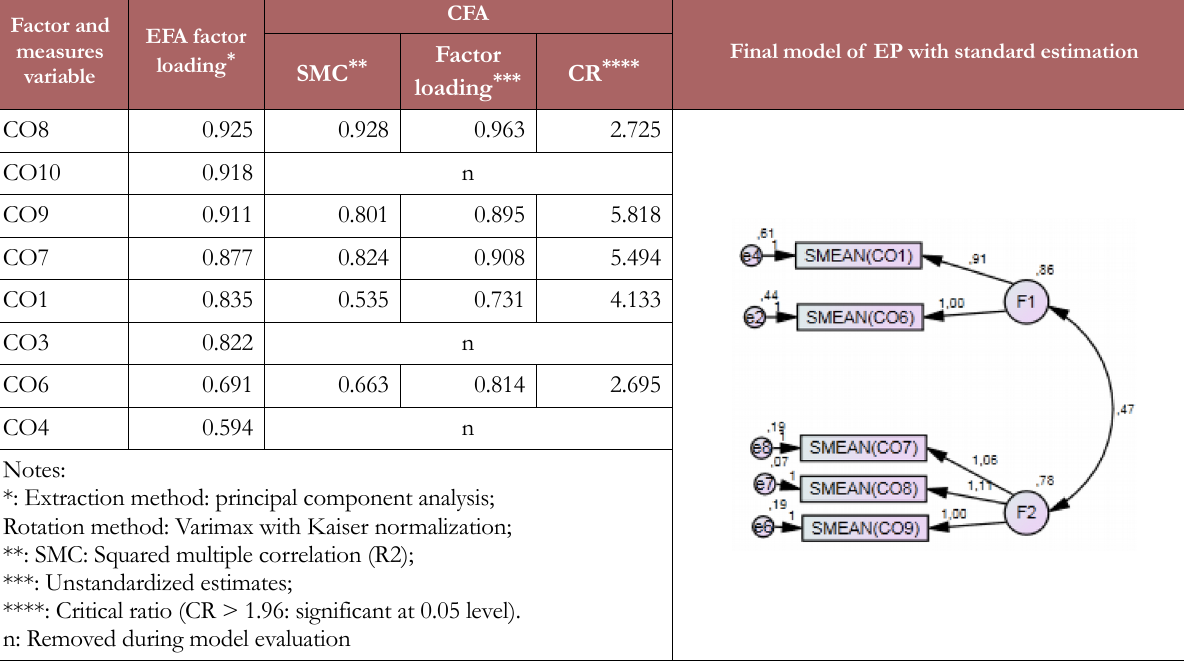
Table 13. EFA and CFA of the CO